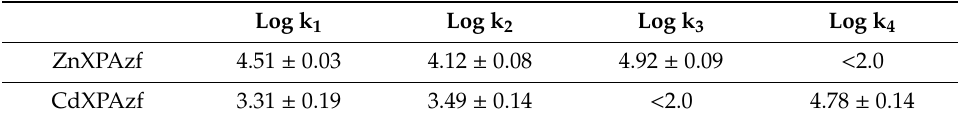
Table 2. Logarithmic values for 2nd order rate constants (M − 2 · h − 1 ) obtained reactions of ZnXPAzf